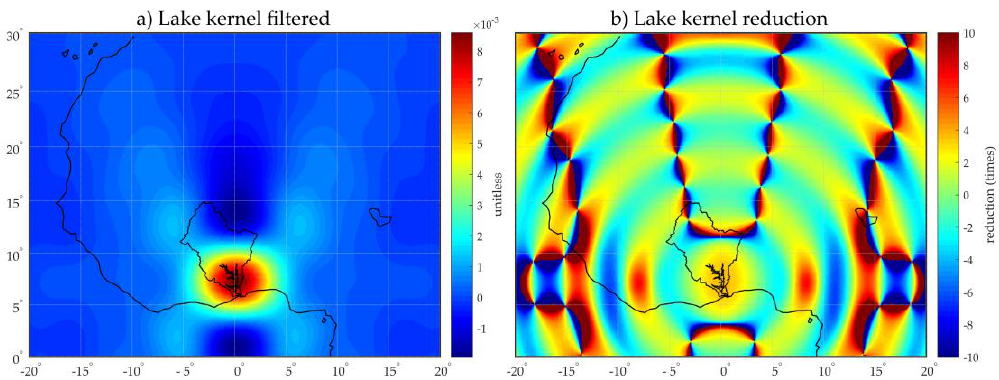
Figure 4. ( a ) The kernel function in Figure 3d, which was computed with 30 arc-seconds of resolution after the same filter scheme used in the Gravity Recovery and Climate Experiment (GRACE), that is, a polynomial and Gaussian filter with a half-length of 300 km, was applied. ( b ) The ratio between the lake kernel filtered (panel a) and the kernel displayed in panel (d) of Figure 3.